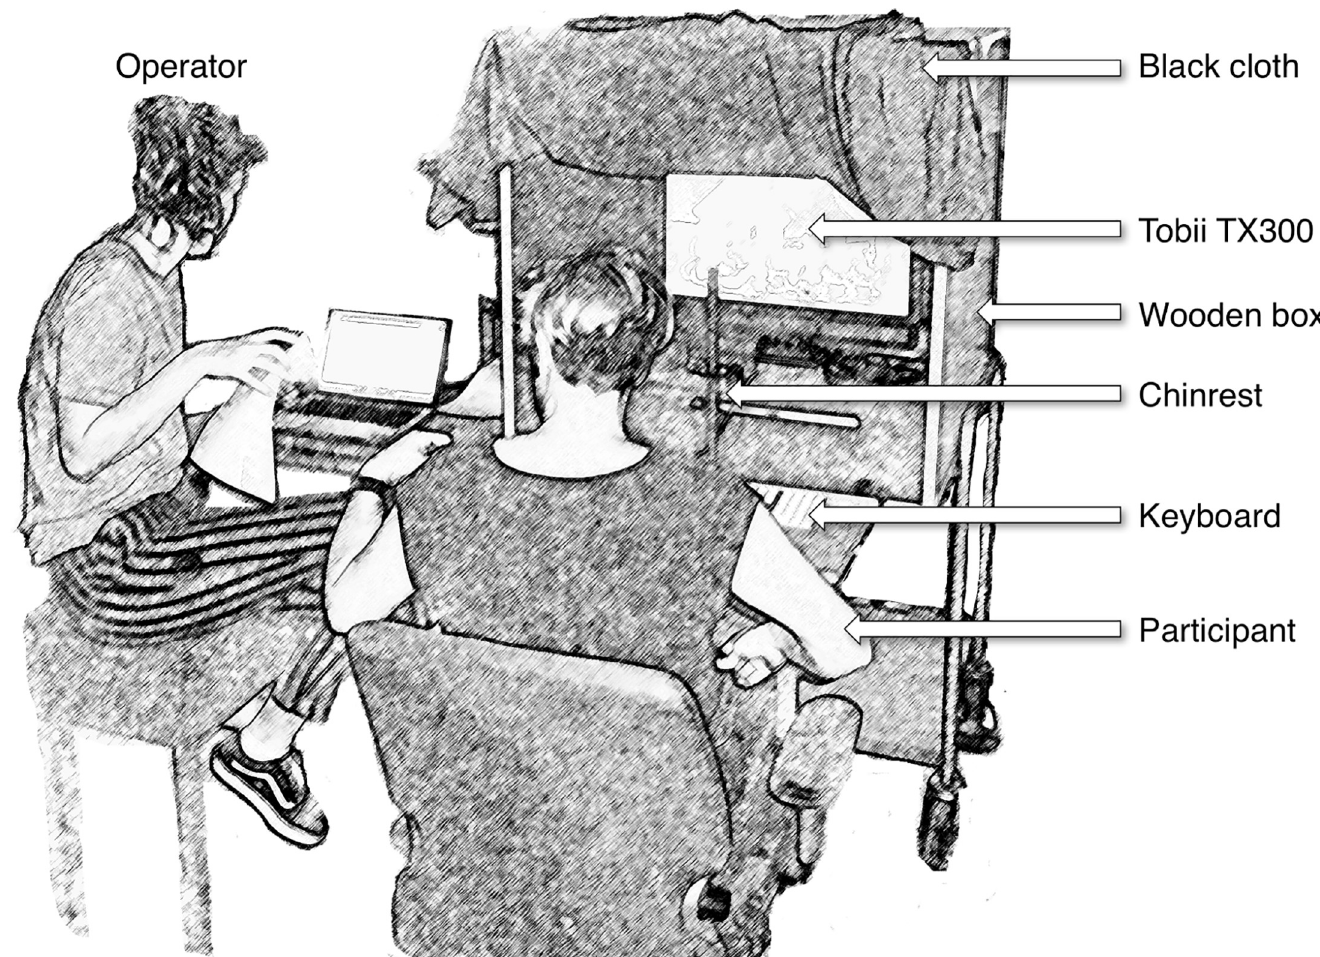
Fig 2. The eye-tracking setup consisted of a box placed on a cart. The box contained a Tobii TX300 eye tracker and presentation screen. A small desk with a keyboard was attached to the front of the box and a chinrest was mounted unto the front of the desk. In this illustration, the participant receives instructions from the operator. When the operator was ready, the participant would take place in the chinrest and the black cloth was draped over the participant. Reprinted from [53] with